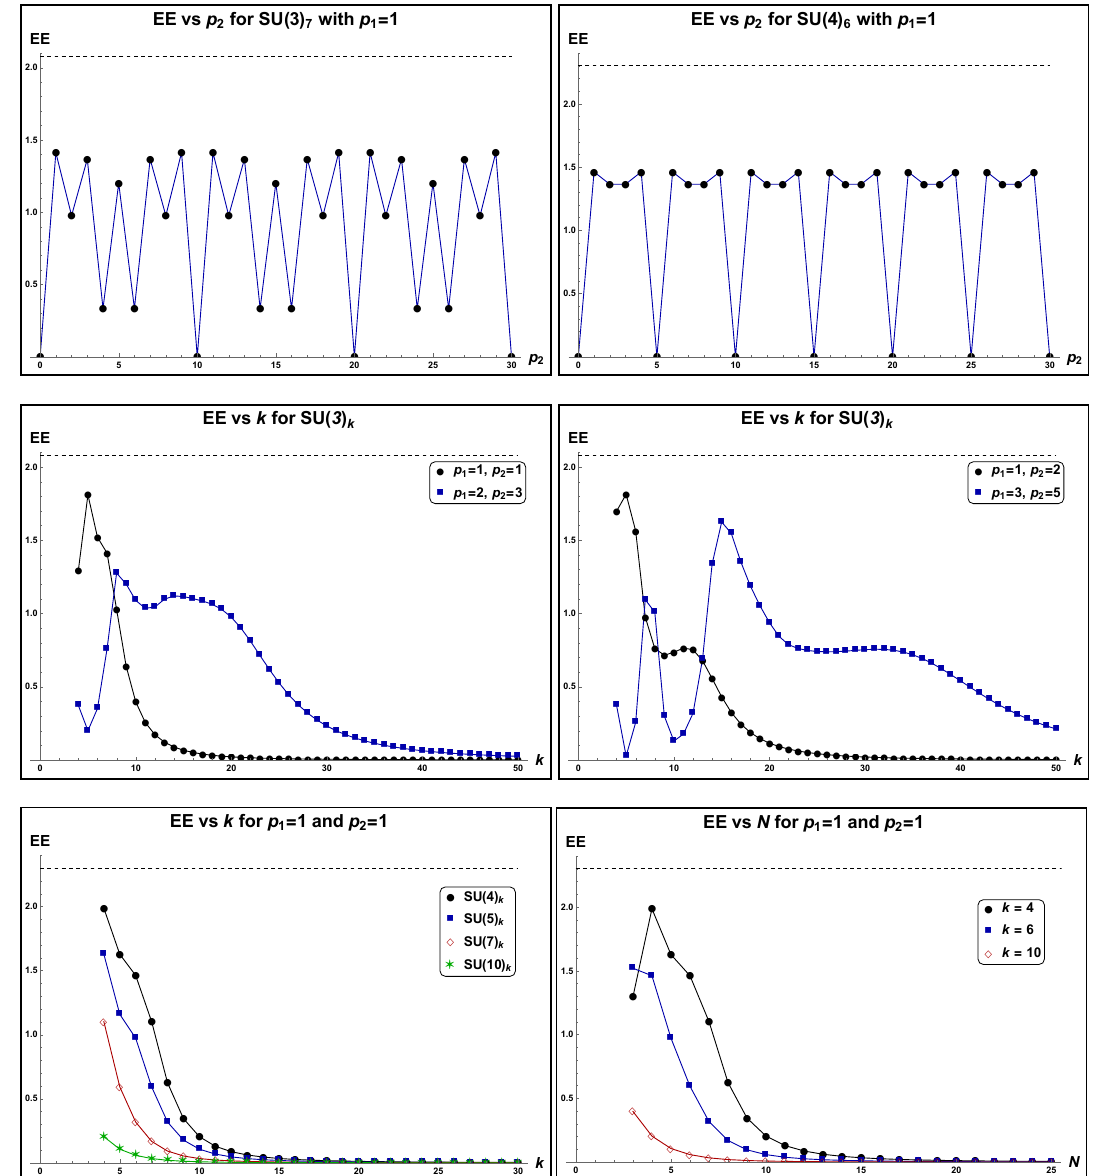
Figure 16 . The variation of SU( N ) k entanglement entropy for (1 j 1) bi-partition of the state j (cid:9) ( n =2) i when all the Wilson lines carry representation. The horizontal dotted line corresponds 4 to maximum possible value of EE which is ln 8 for SU(3) and ln 10 for SU( N (cid:21) 4).